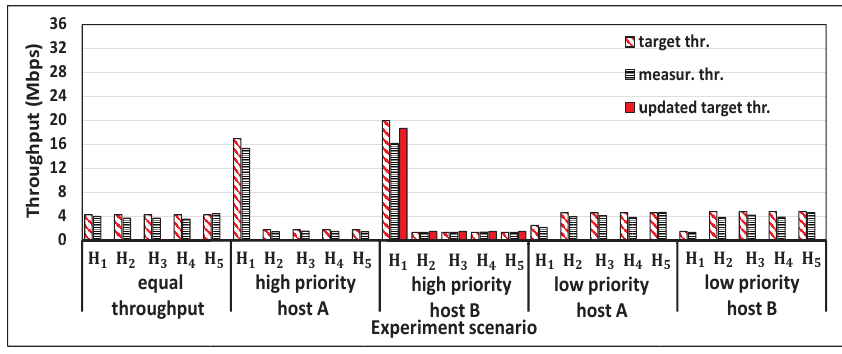
Figure 9. Results for five hosts case with a